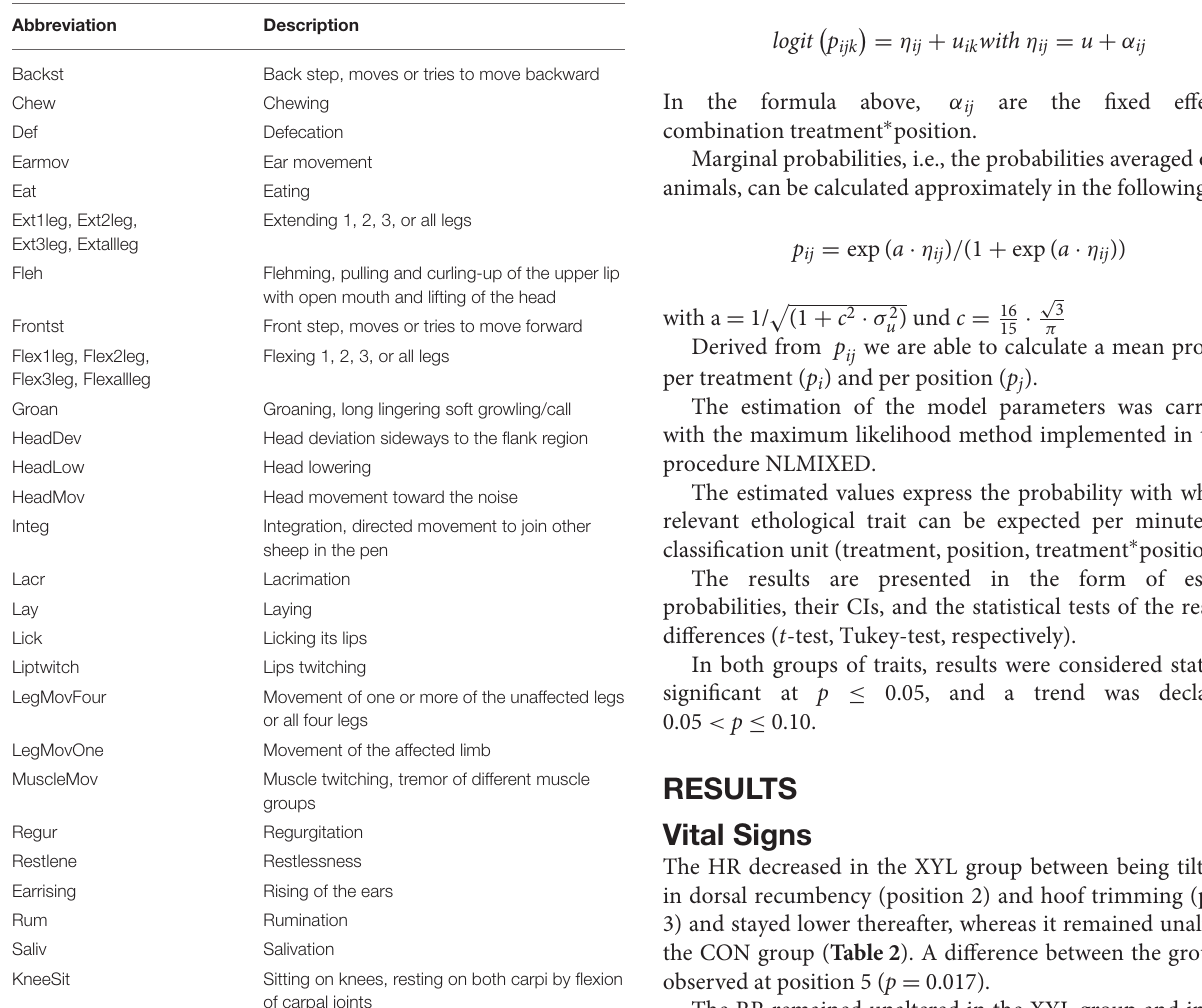
TABLE 1 | Recorded behavioral